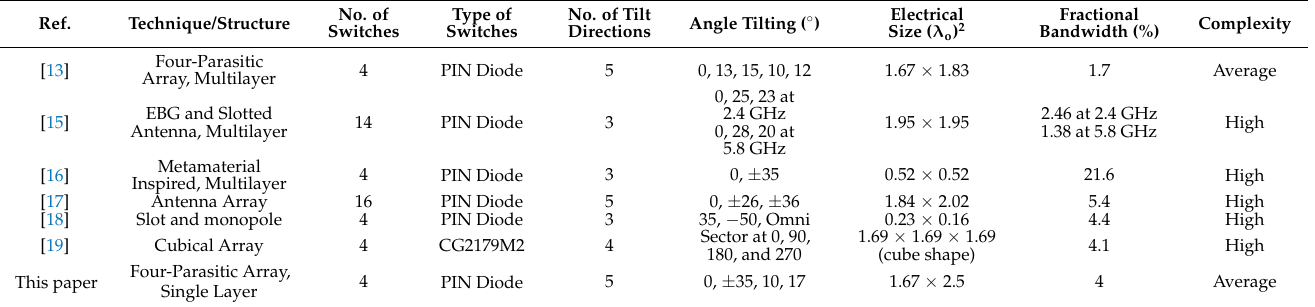
Table 4. Summary comparison with previous works on beam tilting antennas using FR-4 substrate.